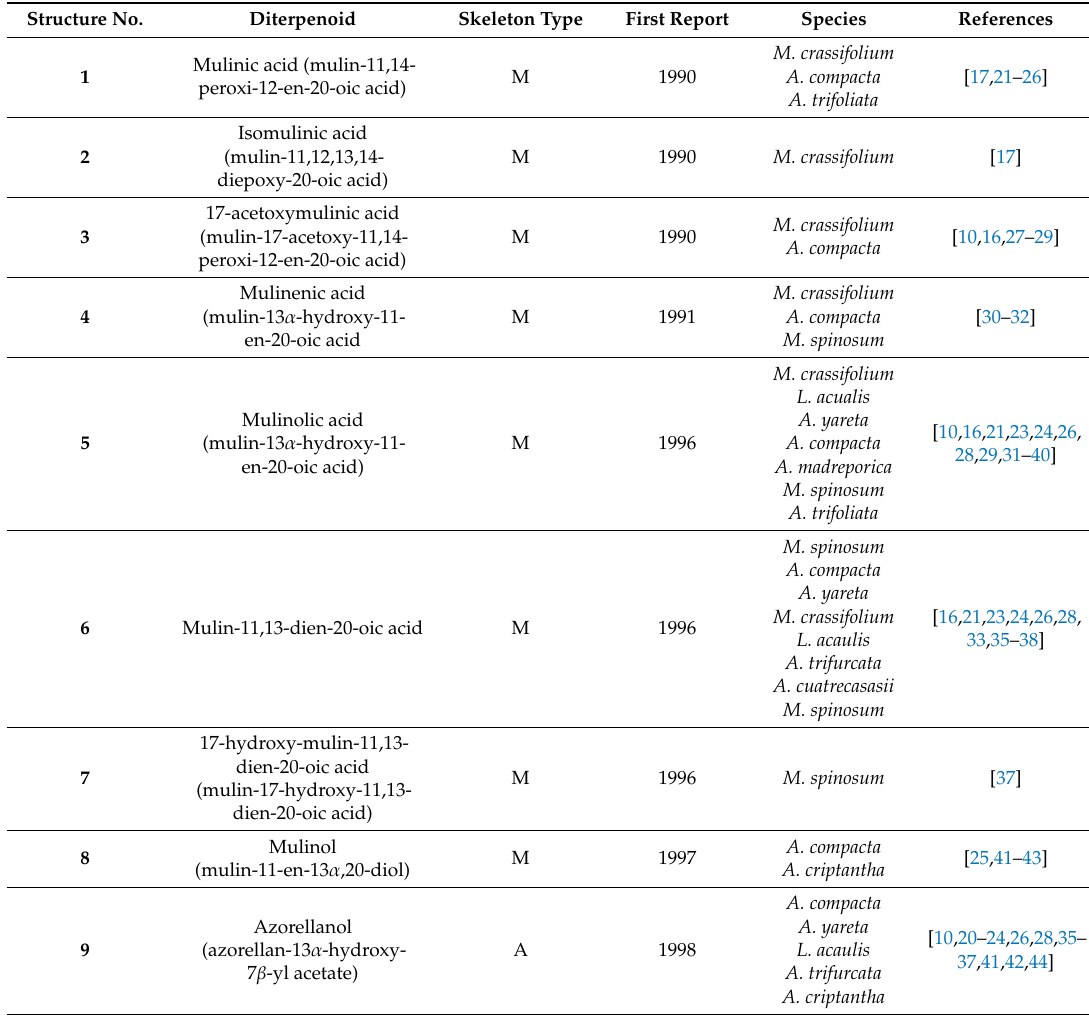
Table 1. Mulinane and azorellane diterpenoids isolated from Mulinum spp., Azorella spp., and Laretia spp. Structure